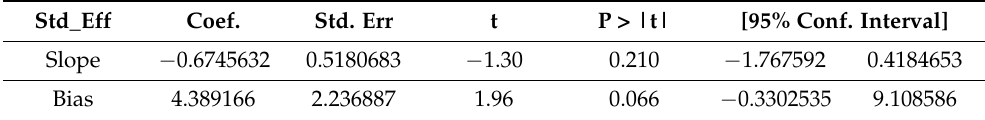
Table 4. Egger’s